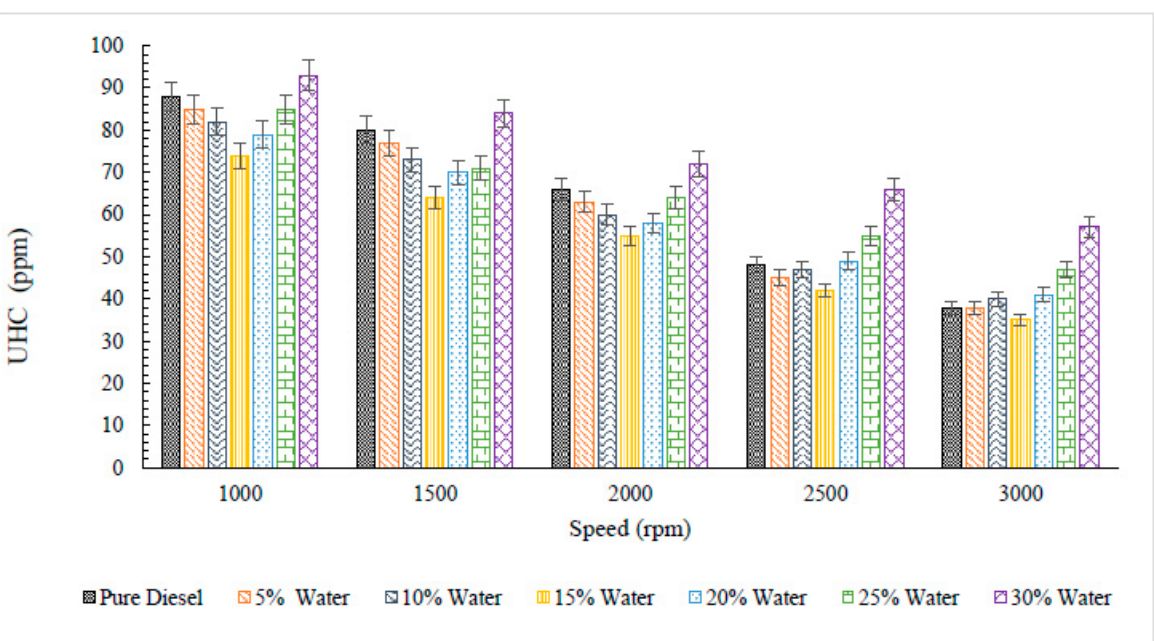
Figure 5. Effect of water-in-diesel emulsion fuel on carbon monoxide emitted from a diesel engine at different engine speed.